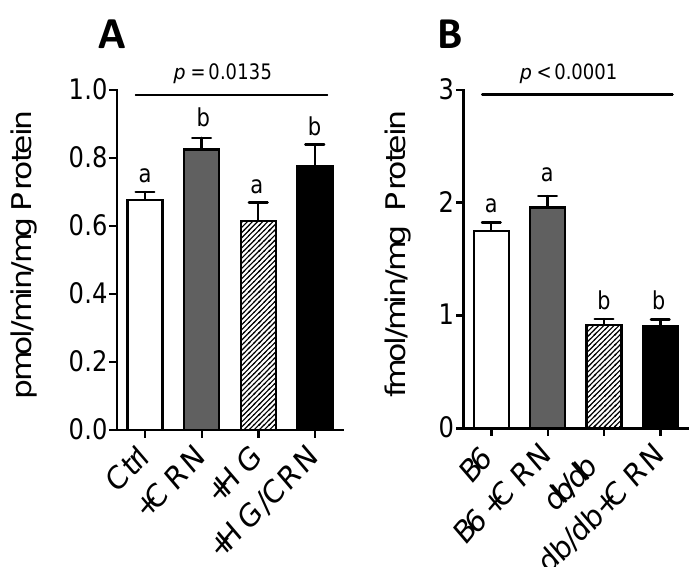
Figure 5. β -oxidation rate in HepG2 cells grown in normal (5.5 mM) and high (30 mM) glucose with and without treatment with 10 mM CRN, 10 µ M CoQ or a combination of the two ( A ). β -oxidation rate in control (C57B) and db/db mice liver treated with CRN, CoQ or CRN+CoQ compared to non- treated controls ( B ). The results represent mean values of five different experiments performed in triplicate. Values are represented as mean ± SEM in each group. Statistical analysis was performed using one-way ANOVA with multiple comparison differences denoted. (a,b) Different letters indicate significant differences in mean values from repeated-measures ANOVA ( p < 0.05). A p -value of <0.05 was considered significant.